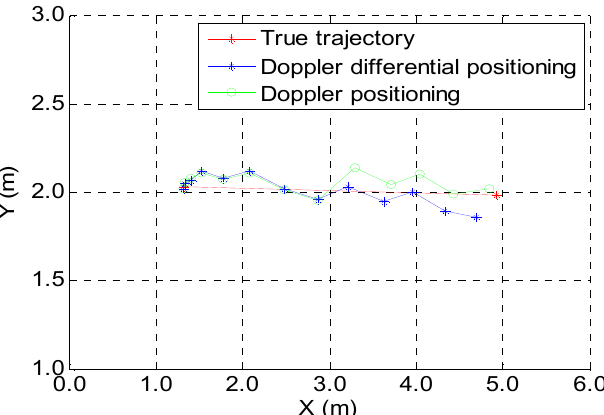
Figure 6. Velocity estimation results using the Doppler differential positioning algorithm in the static test. Table 2. Average value (AVG) and standard deviation (STD) of Doppler differential measurements in the static test.